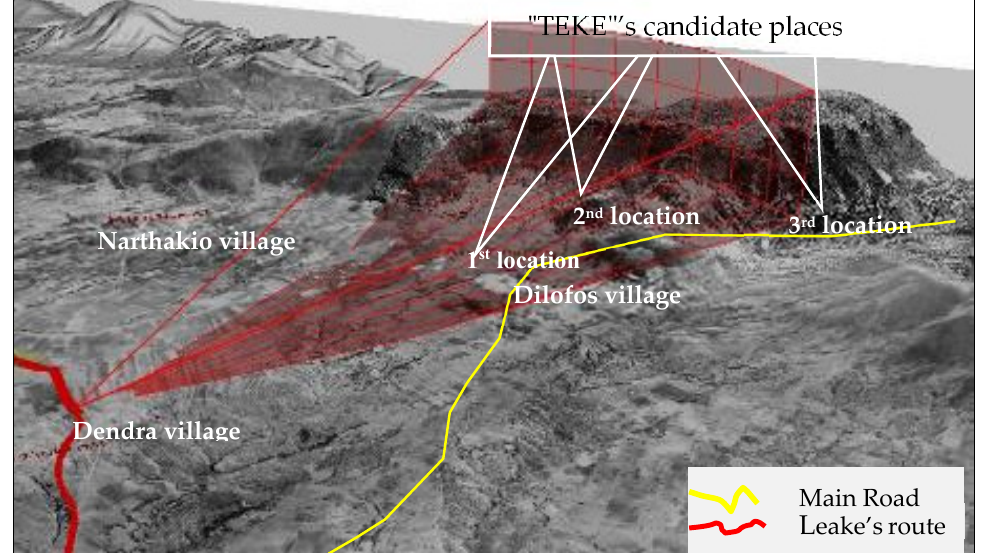
Figure 6. Validation of the “Passage” location on the river Enipeas. The “Dervish School” monument